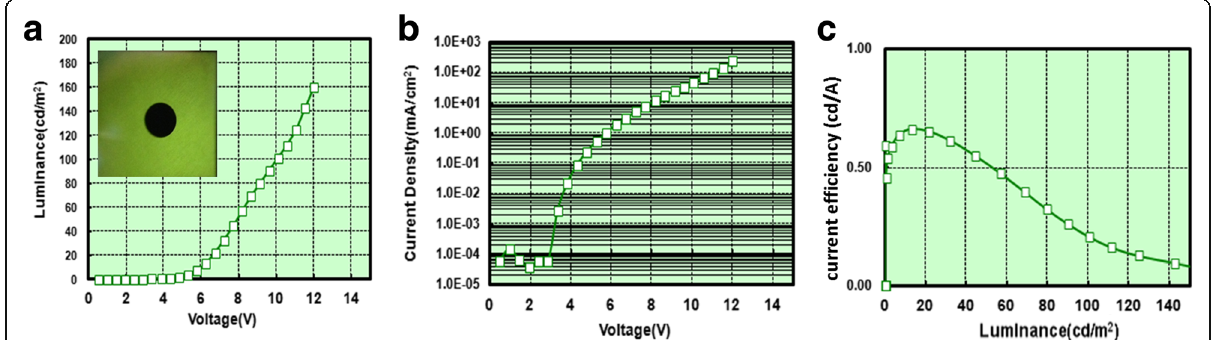
Fig. 6 a Luminance-voltage characteristic. The inset shows the green multilayered InP/ZnS core/shell QD-LEDs. b Current density-voltage characteristic and c current efficiency as a function of luminance for multilayered InP/ZnS core/shell